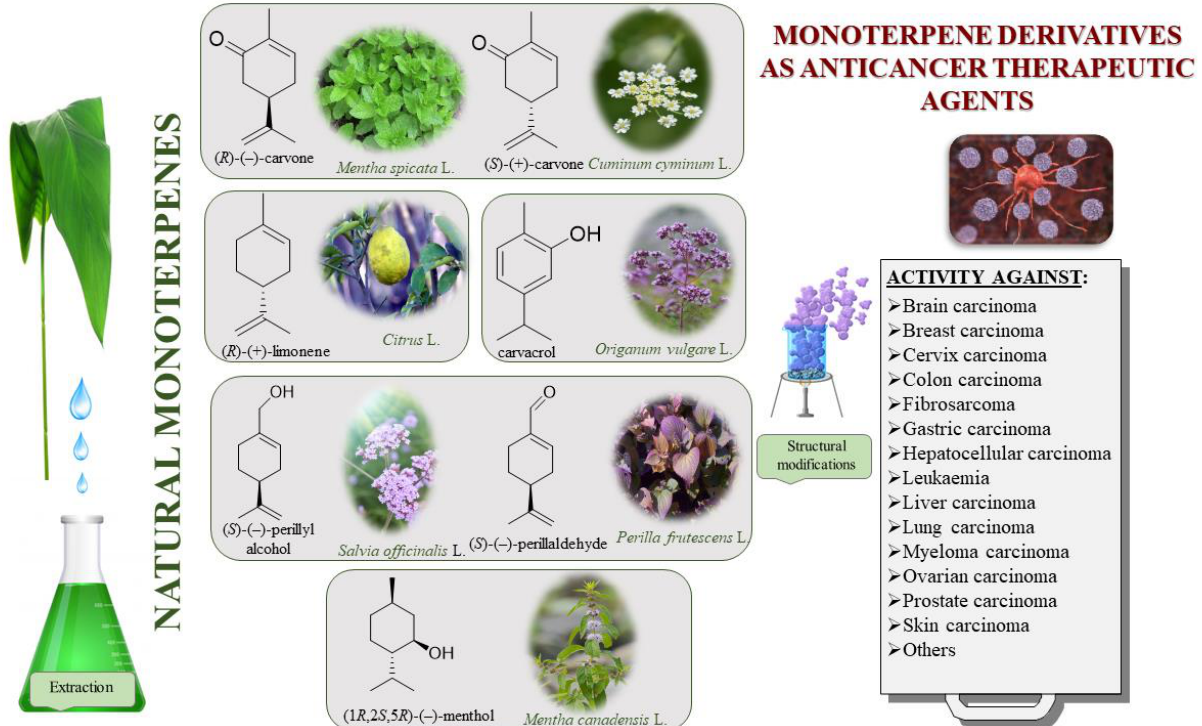
Figure 1. Division of various monoterpenes and their antitumor activity.